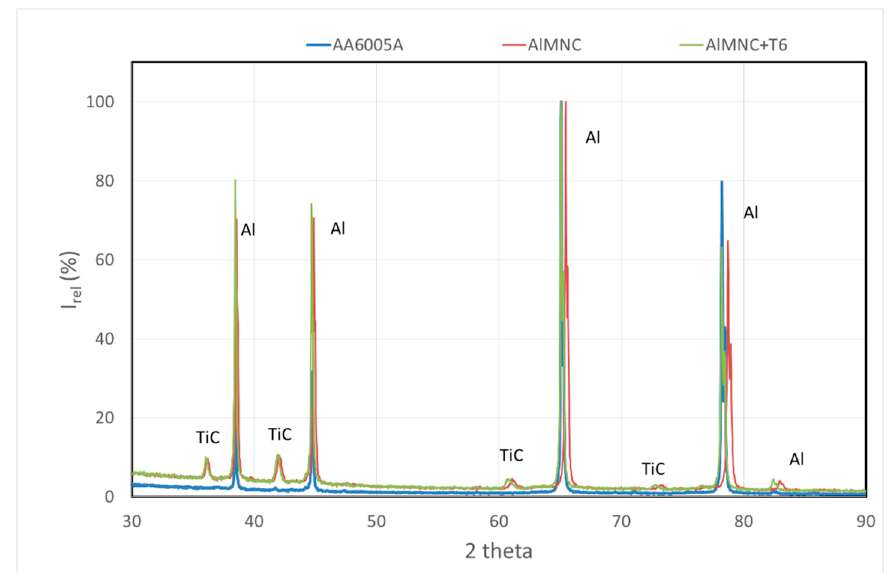
Figure 1. X ‐ ray diffraction (XRD) patterns obtained on longitudinal sections of extruded profiles of unreinforced A6005A alloy, aluminium matrix nanocomposite (AlMNC), and AlMNC after T6 heat treatment of milled powder.